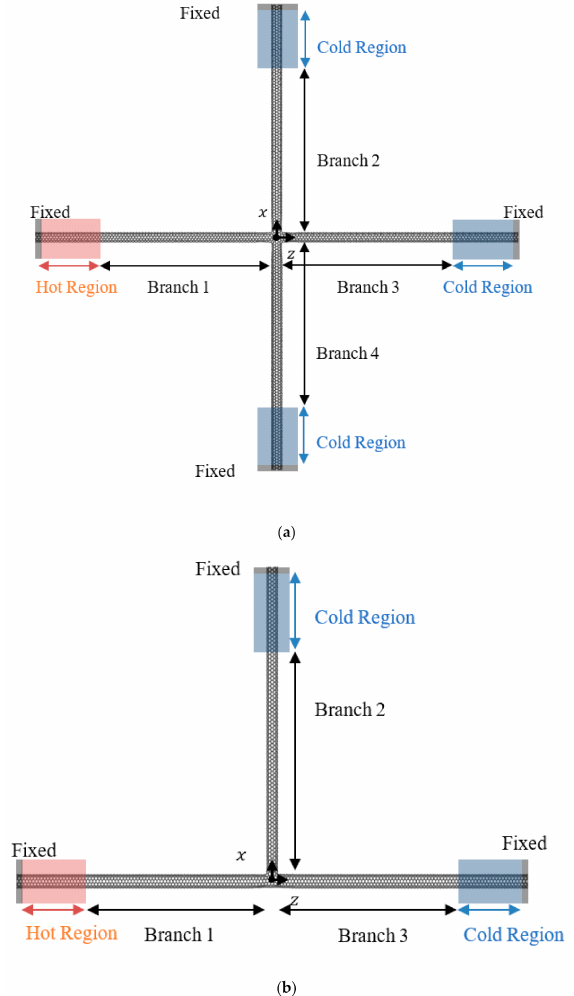
Figure 4. Illustration of the temperature-controlled setup for non-equilibrium molecular dynamics simulations. A hot region was created at branch 1, whereas cold regions were created in the remaining branches of the branched CNTs with ( a ) cross-junction and ( b )